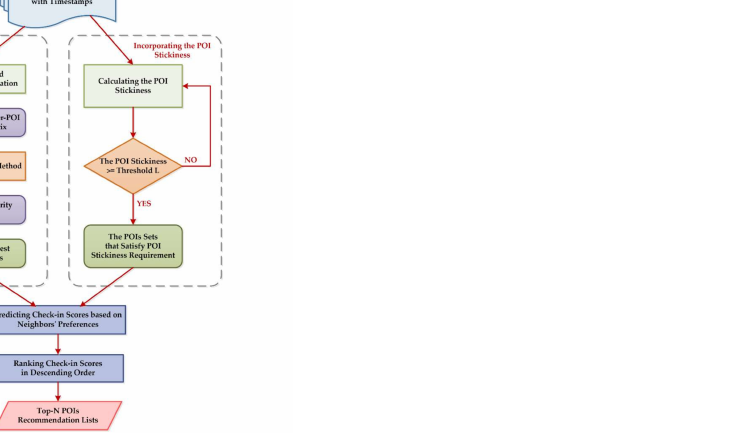
Figure 1. Flowchart of point-of-interest (POI) recommendation with memory-based preference and POI